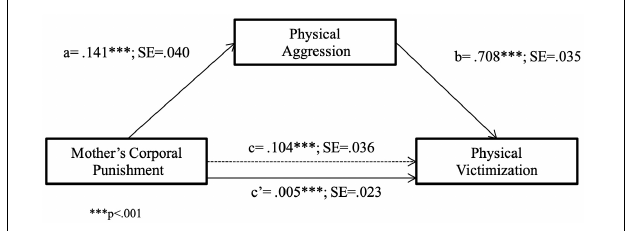
FIGURE 4 | Physical victimization predicted from mother’s corporal punishment through physical aggression. ∗∗∗ p < 0.001.